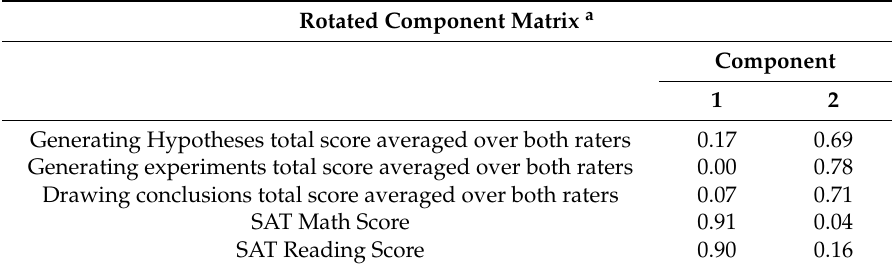
Table 12. Principal component analyses in Study 2 without new scales, but with SAT.